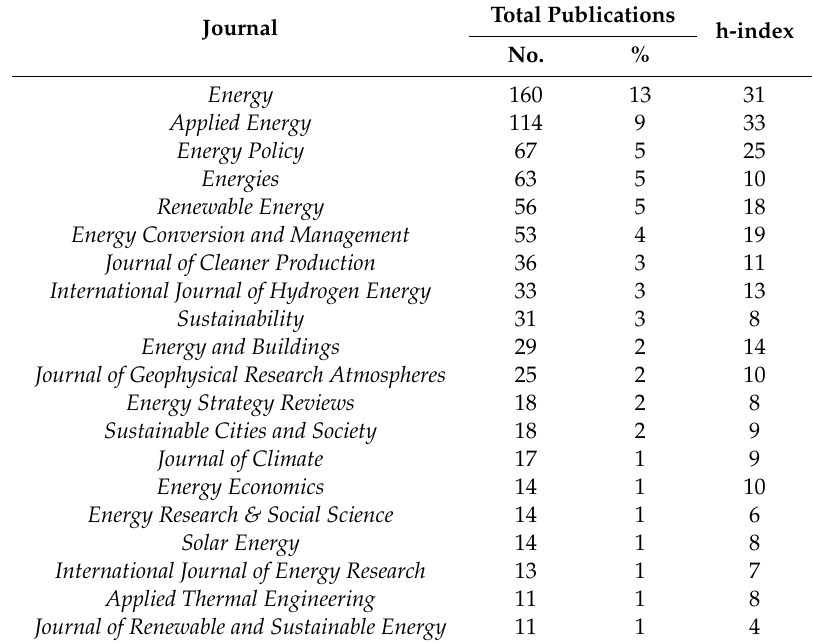
Table 5. The top 20 of the most productive scientific journals in terms of publications on municipal energy system planning. The percentage values refer to the total of 1235